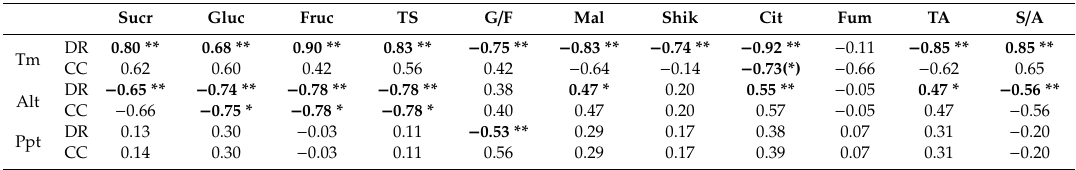
Table 5. Correlation coe ffi cients between rainfall, temperature, altitude and the content of sugars and organic acids. Sucr Gluc Fruc TS G / F Mal Shik Cit Fum TA S / A DR 0.80 Tm